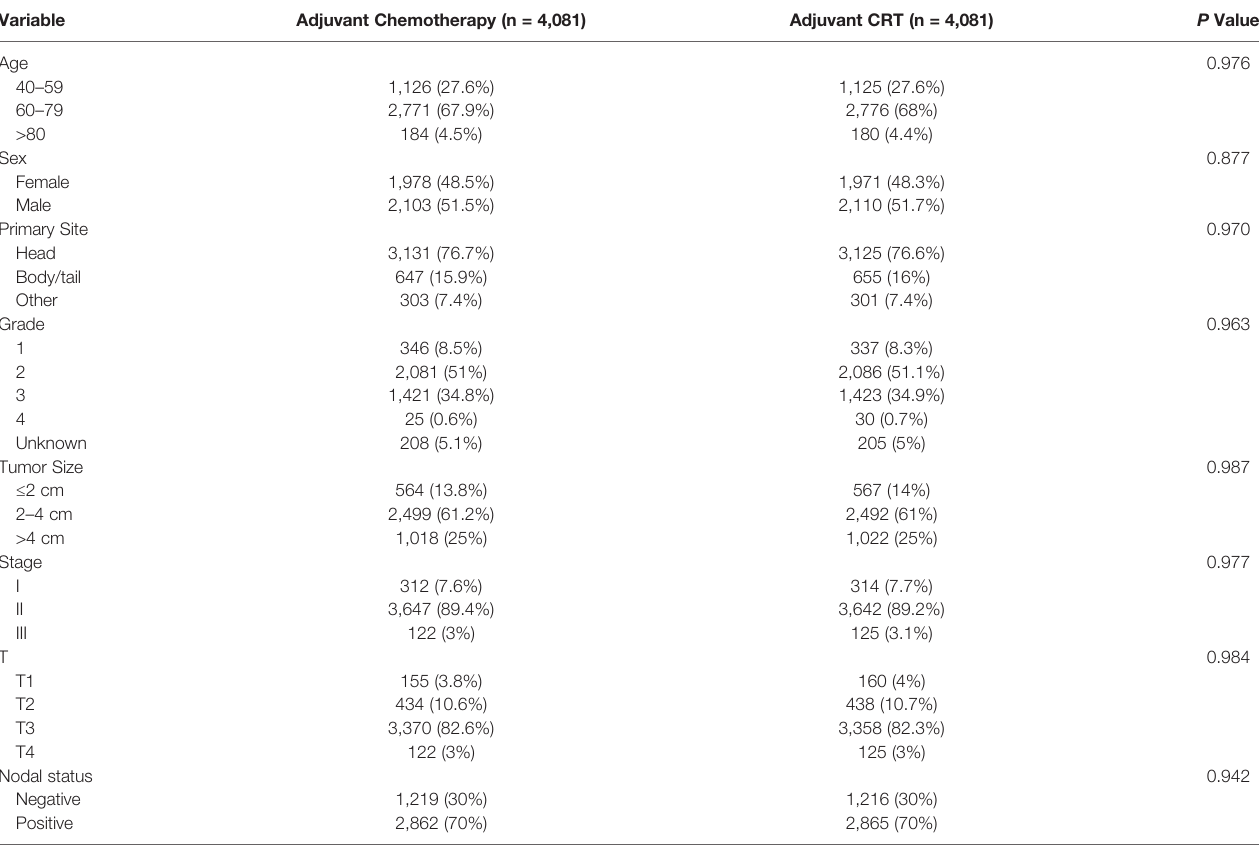
TABLE 3 | Demographic and clinicopathological features of patients receiving adjuvant chemotherapy and adjuvant chemoradiotherapy after propensity score matching.